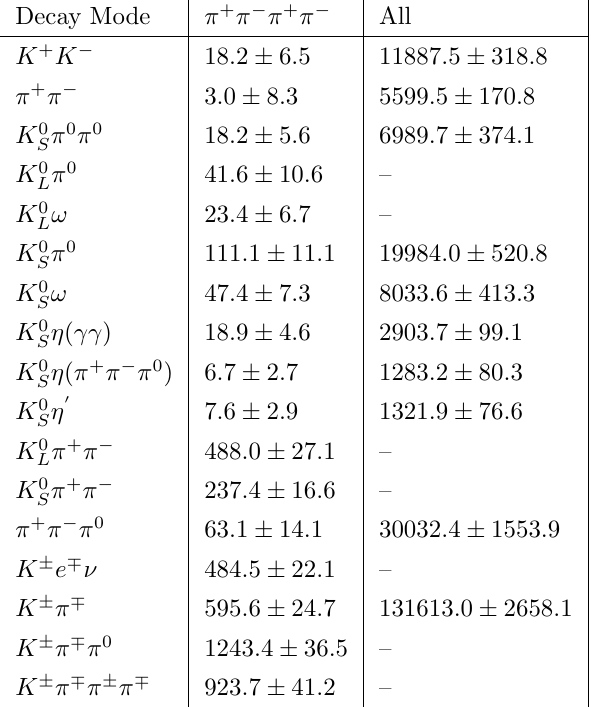
Table 3 . List of the di(cid:11)erent parameterisations used for the hadronic parameters of di(cid:11)erent categories of (cid:12)nal state, and how they relate the K f derive the formalism in this